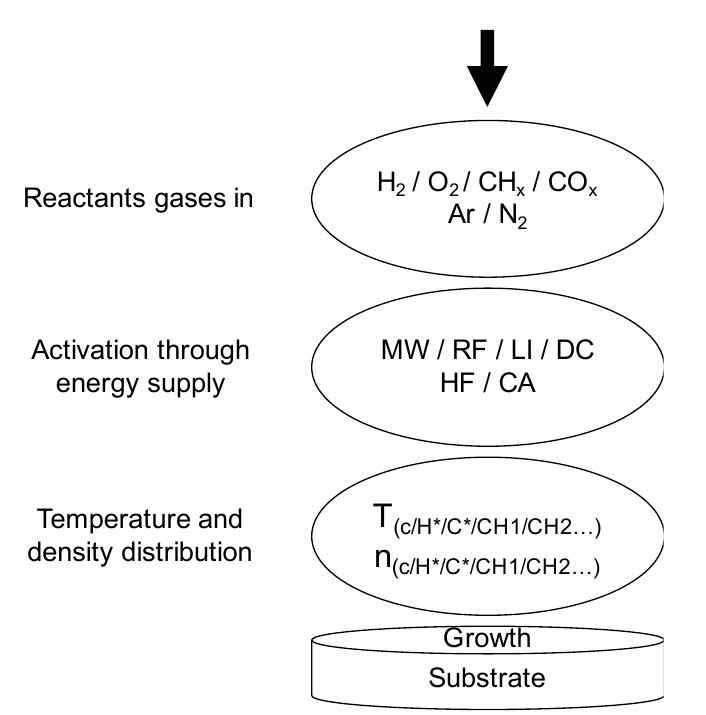
Figure 2. Schematic diagram of the mechanism for diamond CVD growth processes. The acronyms used in the figure correspond to: MW, microwave; RF, radiofrequency; LI, laser induced; HF, hot filament; DC, direct current; CA, chemical activation.